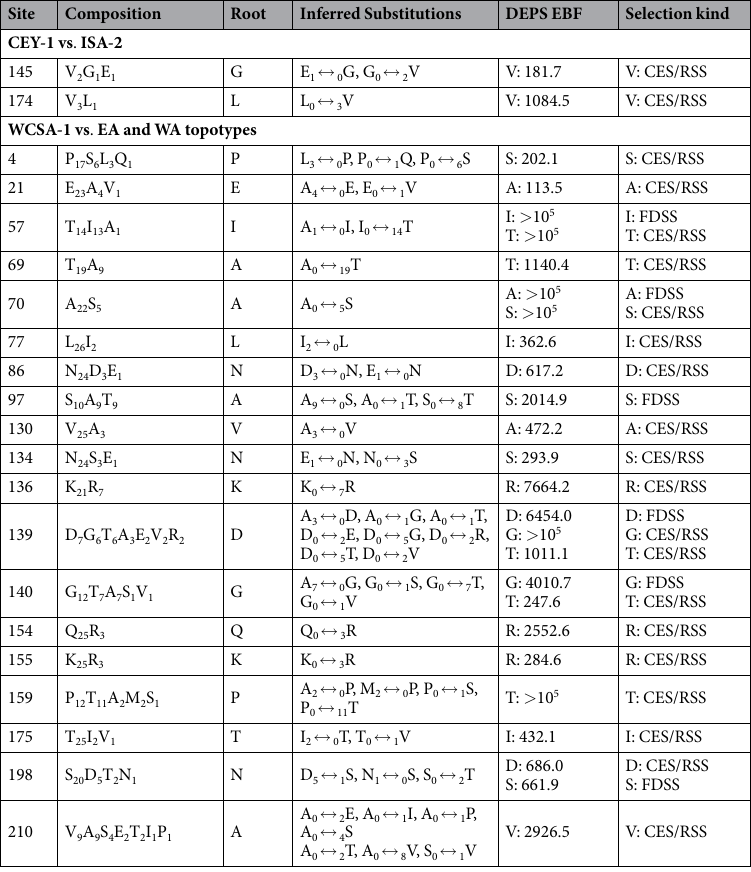
Table 3. Sites undergone directional selection revealed in DEPS analyses. CES: Convergent Evolution Site; RSS: Repeated Substitution Site; FDSS: Frequency Dependent Selection